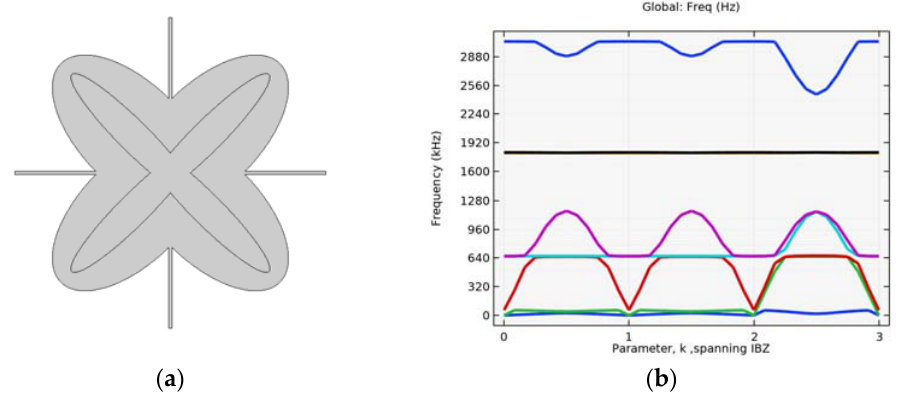
Figure 5. Response for Inner ellipse 170 × 30, rod thickness 3 mm. (a) microstructure, (b) responce for first eigenfrequenciew. Two band gaps are identified. Between 5th and 6th eigenfrequency (1160–1800 Hz) and between 7th and 8th eigenfrequency (1800–2460 Hz).